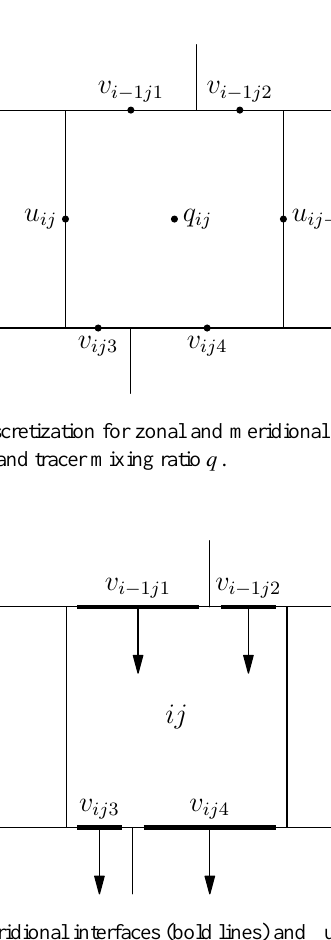
Figure 5. Meridional interfaces (bold lines) and fluxes (arrows) for cell (i,j)